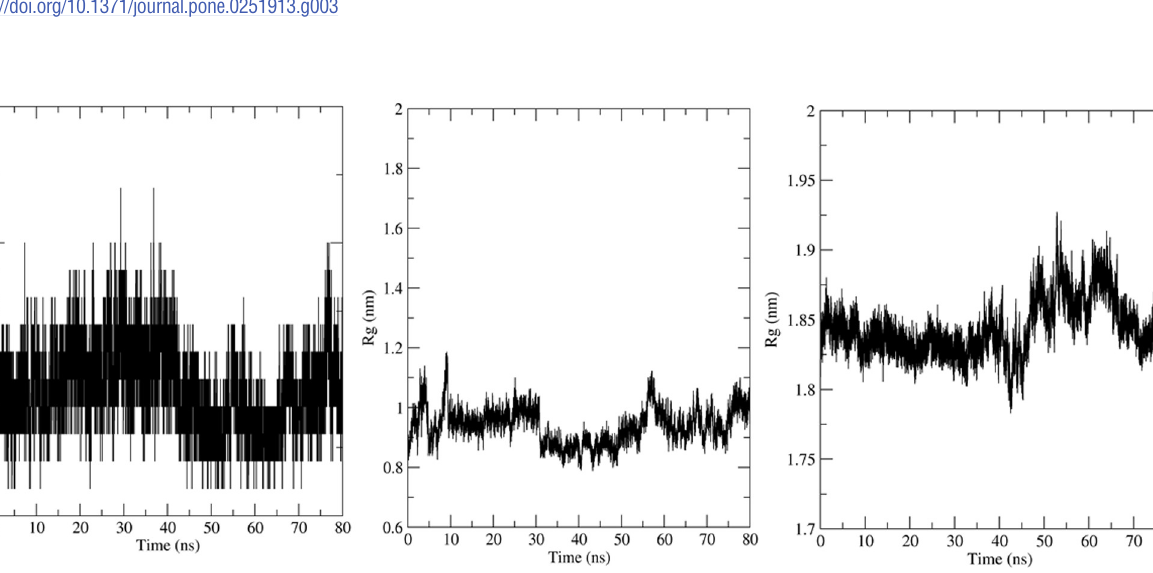
PLOS ONE | https://doi.org/10.1371/journal.pone.0251913 May 18, 2021 6 /